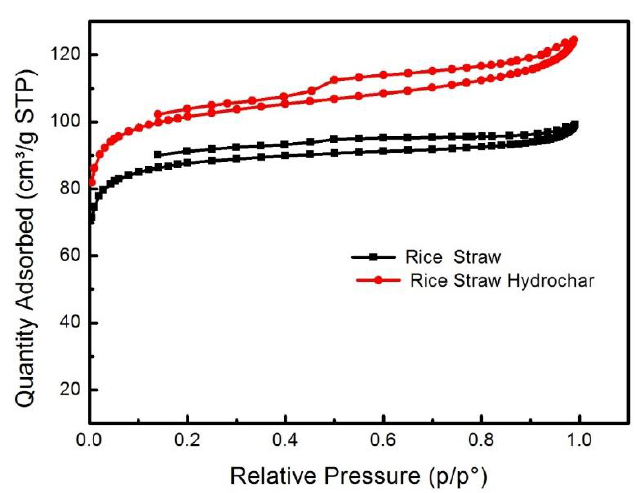
Figure 10. The N 2 adsorption iotherm of rice straw and optimized hydrochars.